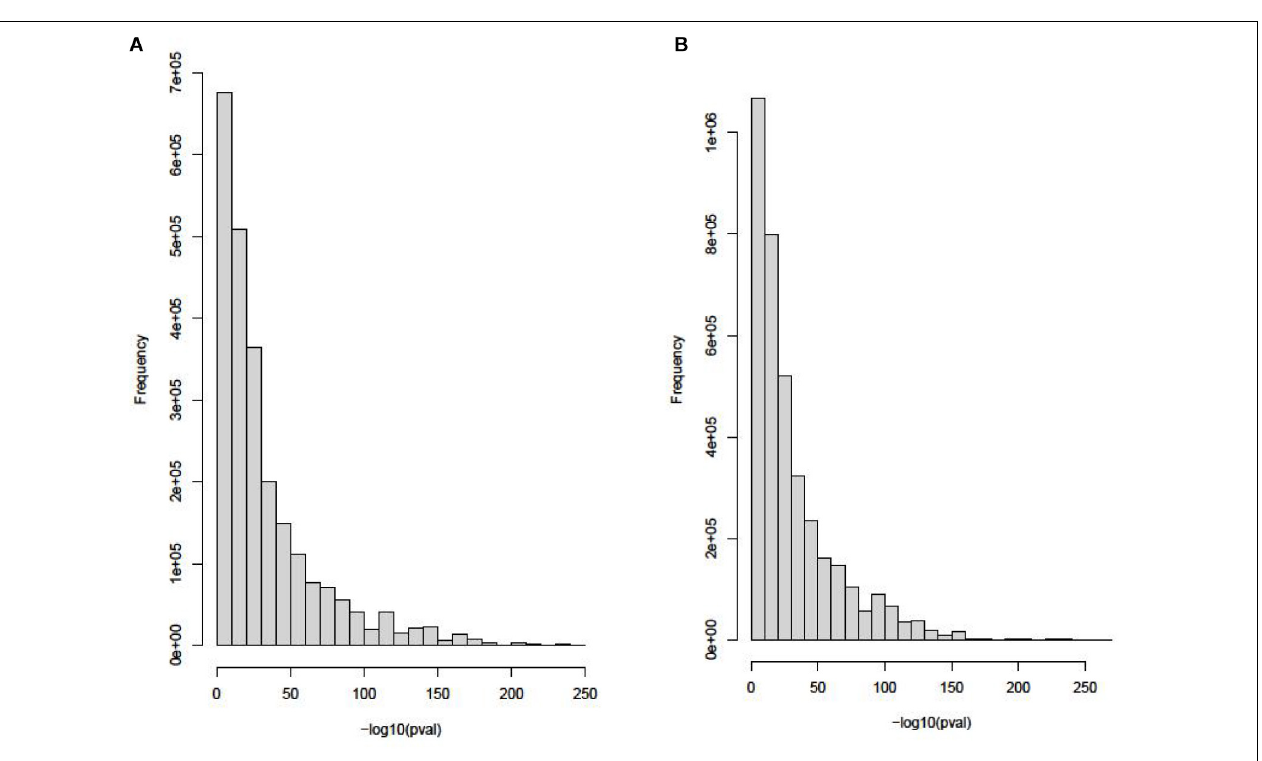
FIGURE 2 | The distributions of blood tissue and thyroid tissue in the eQTL data. (A) Histogram of P value in eQTL of blood tissue. (B) Histogram of P value in eQTL of thyroid